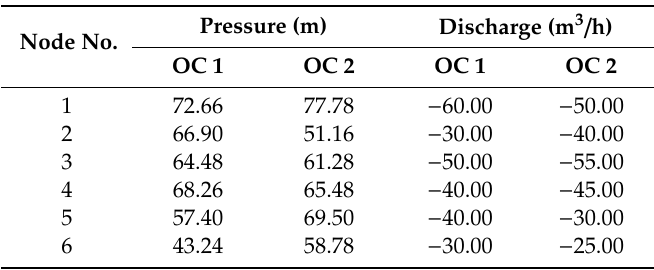
Table 2. Operating data without Table 1. Pipes information of the example branch DHN.